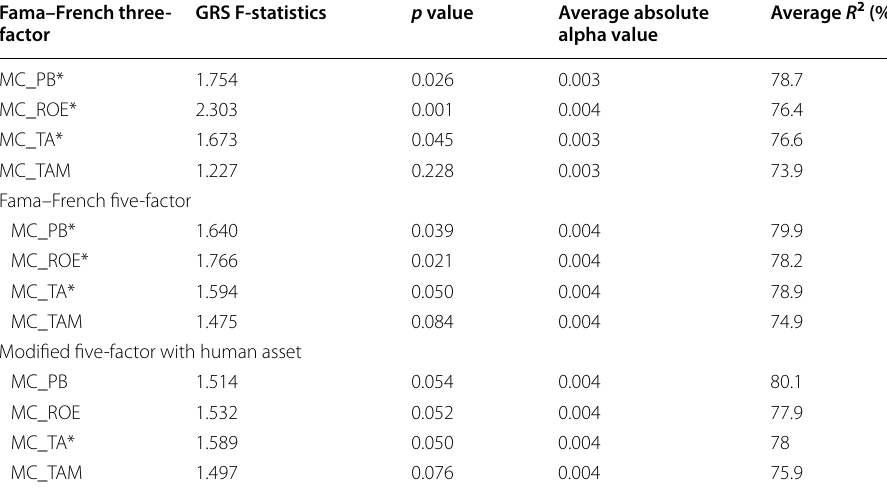
Table 8 Summary of GRS test results for all the Factor